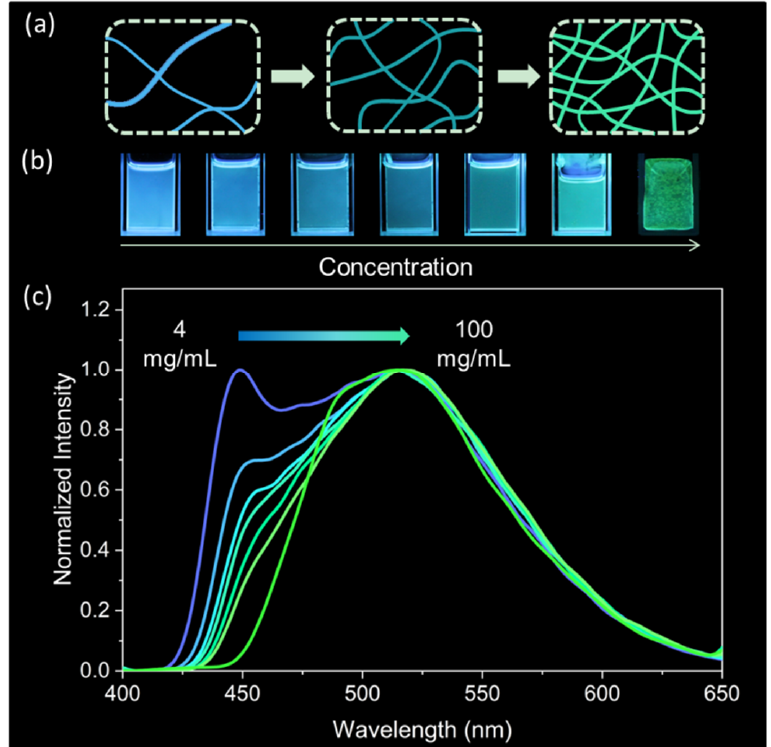
Figure 4. ( a ) Schematic illustration of cross-linked polymers during the formation of the supramolecular polymer networks with the increasing concentrations of PPMU solutions; ( b ) Fluorescent photographs and ( c ) Normalized fluorescent spectra of PPMU at different concentrations (4 mg/mL, 8 mg/mL, 12 mg/mL, 16 mg/mL, 24 mg/mL, 32 mg/mL, 100 mg/mL) in CHCl 3 at 298 K. λ ex = 365 nm. Slit: 10/8 nm.